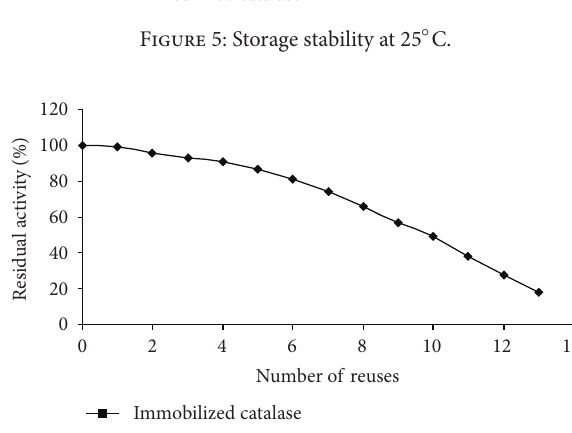
F 5: Storage stability at 25